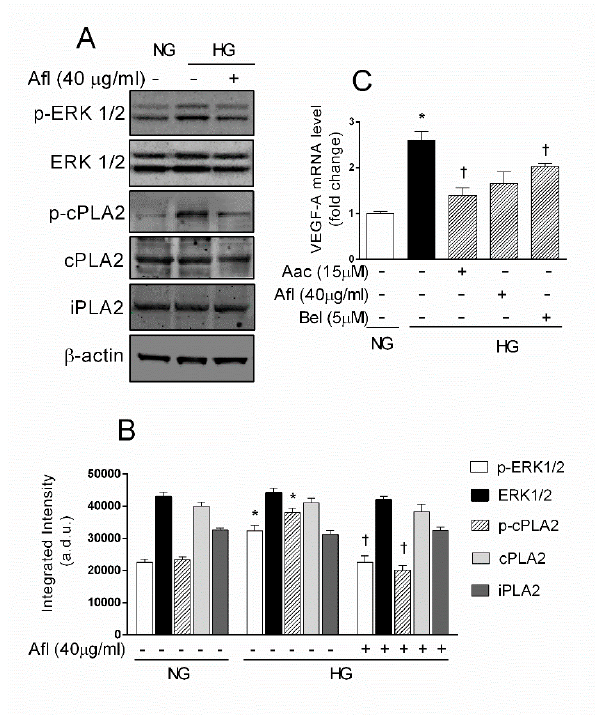
Figure 3. Aflibercept reduced phospho-cPLA2, phospho-ERK 1 / 2 and VEGF-A levels in human retinal endothelial cells (HRECs) treated with high glucose (HG). Cells were treated for 48 h with normal glucose (NG, 5 mM), high glucose (HG, 25 mM) alone or supplemented with Aflibercept (Afl, 40 µ g / mL) or the cPLA2 inhibitor (Aac 15 µ M). Panel ( A ) immunoblot analysis of whole-cell lysates from treated HRECs using antibodies against phospho ERK 1 / 2, total ERK1 / 2, phospho-cPLA2, total cPLA2 and iPLA2. The blot was probed with anti β -actin antibody for verify equal loading of 30 µ g protein per lane. Panel ( B ) Densitometry analysis of immunoblot indicating protein quantification of each band (in arbitrary densitometry unit, a.d.u.), carried out with the Image J program. Bar graphs represent the means ± SEM from three independent experiments. Panel ( C ) RT-qPCR analysis of VEGF-A mRNA extracted from treated HRECs. Each bar represents the means ± SEM from three independent experiments. * p < 0.05 vs. Control (NG); † p < 0.05 vs. HG. One-way ANOVA, followed by Tukey’s